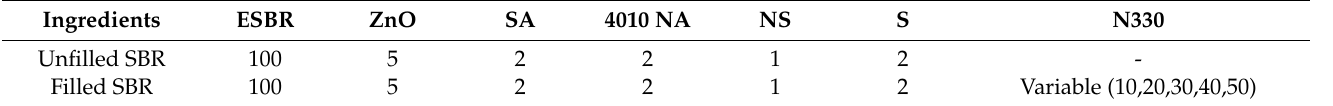
Table 1. Formulations in parts per hundred rubber